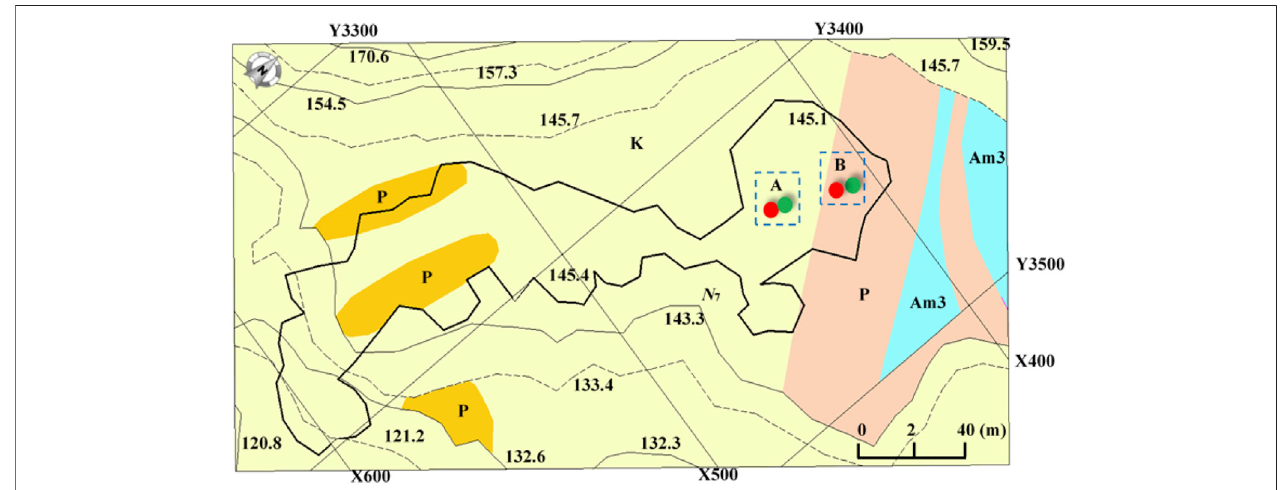
FIGURE 3 | Layout plan of monitoring